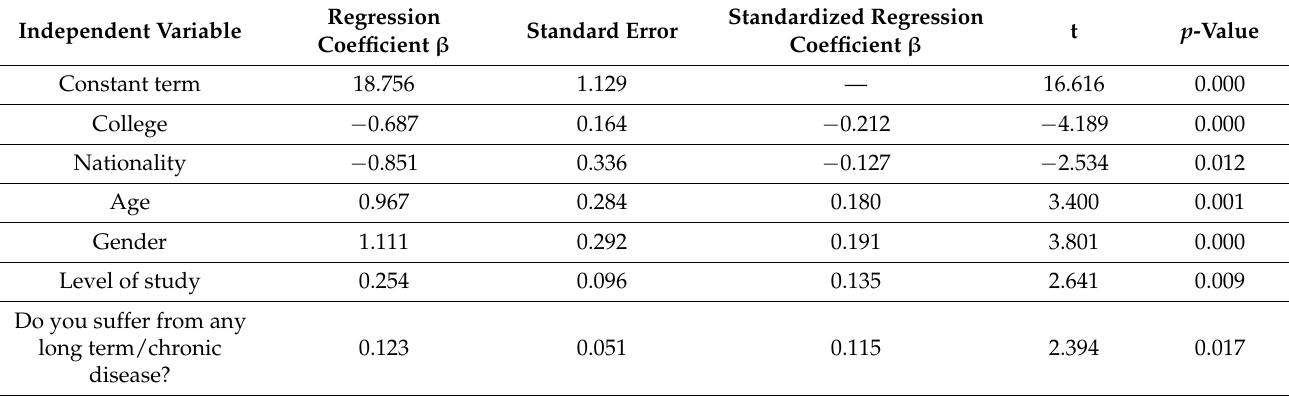
Table 5. Multiple stepwise linear regression analysis of factors affecting student’s knowledge and attitude towards SM. Standardized Regression Regression Standard Error Independent Variable Coefficient Coefficient β